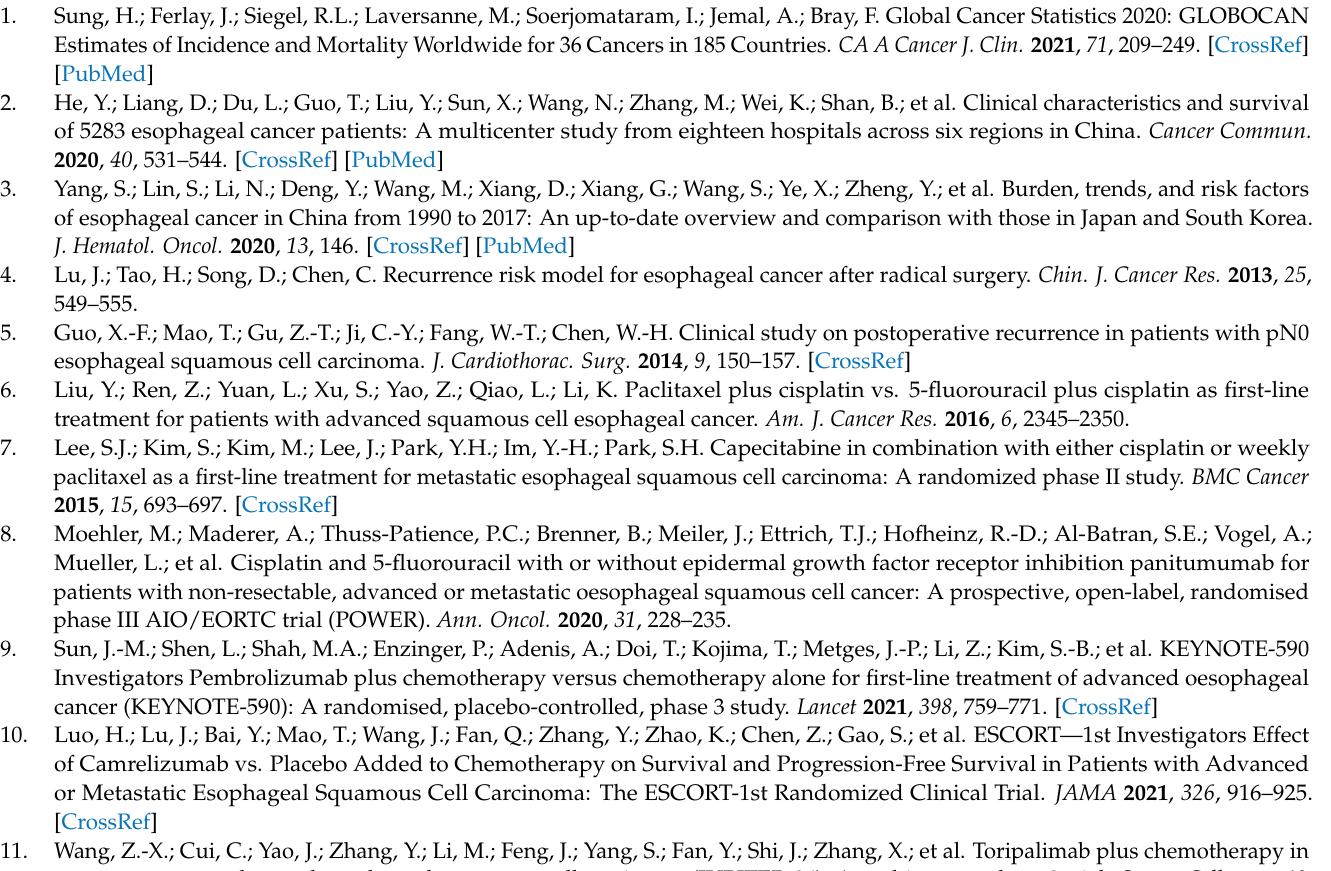
Immunotherapy efficacy prediction of TIDE and ImmuCellAI. Table S6: Top 10 significant p -values and q-values for LINCS L1000 Chem Pert